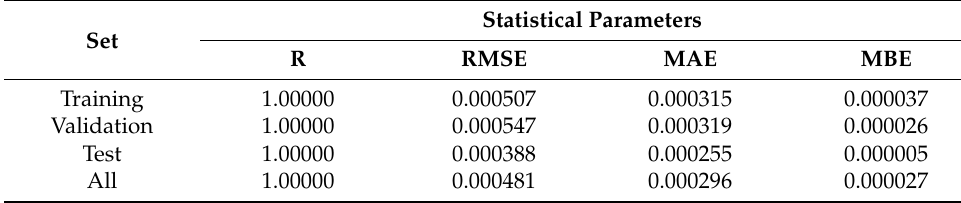
Figure 7. Regression plots of ( a ) training data, ( b ) validation data, ( c ) test data, and ( d ) complete datasets of the (2-10-10-1) ANN model. Table 11. Statistical parameters of the (2-10-10-1) ANN